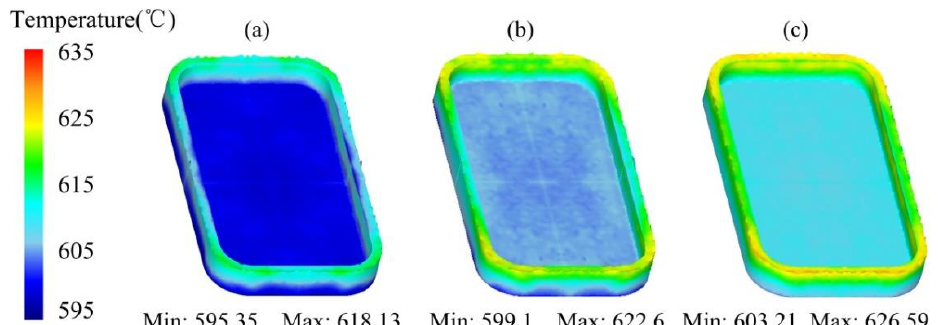
Figure 8. Temperature distribution of the mobile phone shell at the billet temperatures of ( a ) 625 °C, ( b ) 630°C, and ( c ) 635 °C.